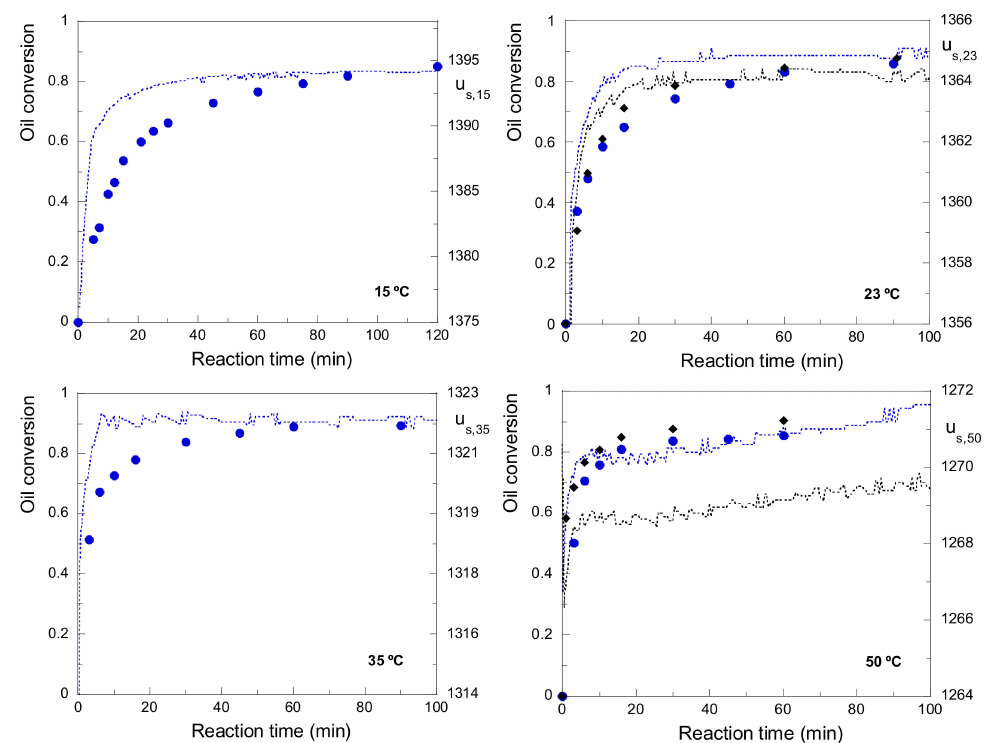
Figure 2. Experimental oil conversions ( • ) and speed of sound propagation data (——) for reactions carried out at a 6:1 ethanol/oil molar ratio and different reaction temperatures. In black ( (cid:7) , —) are the oil conversion and sound propagation data in the replicated